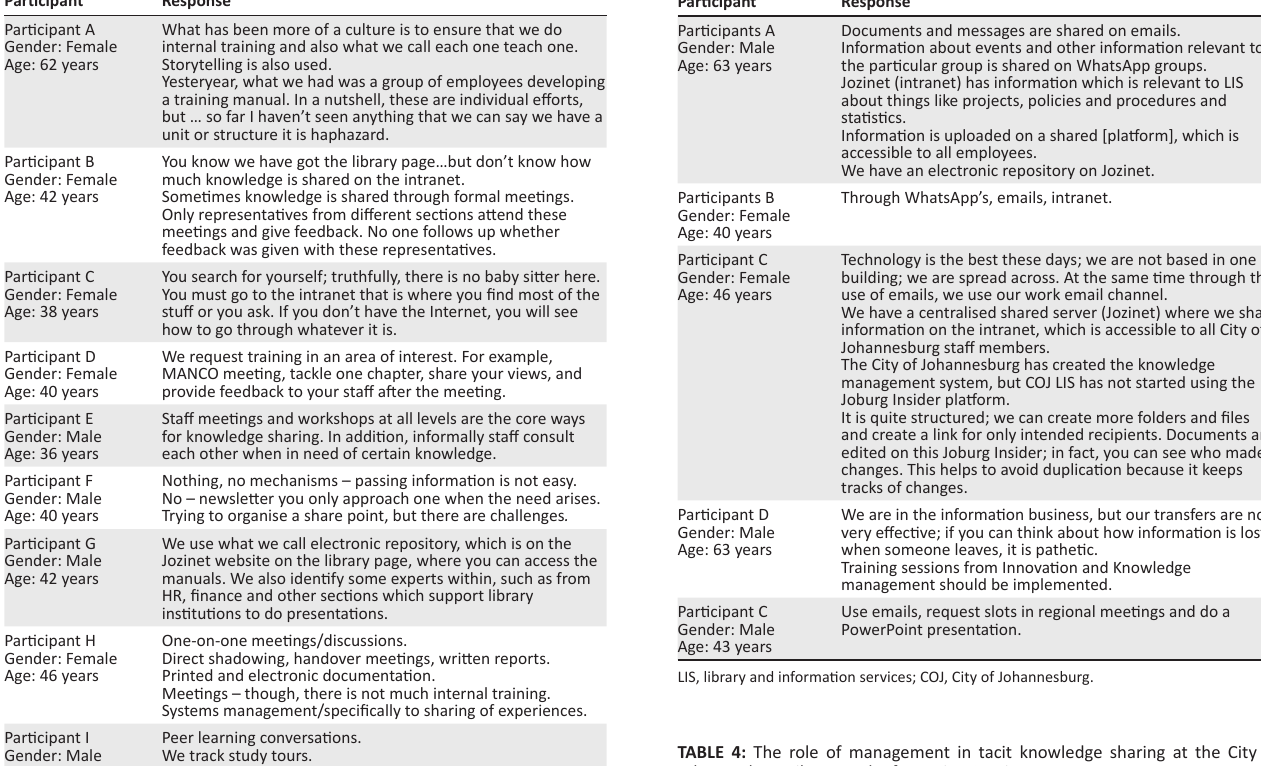
TABLE 3: How technology enables tacit knowledge sharing at the City of Johannesburg Library and Information Services. Participant